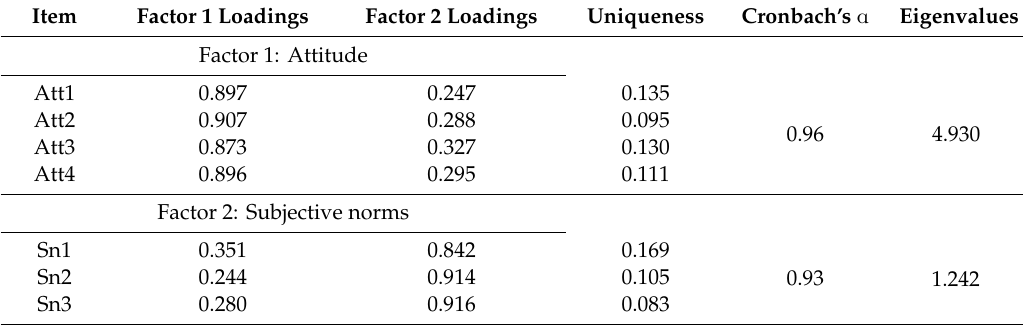
Table 4. Exploratory factor analysis results.